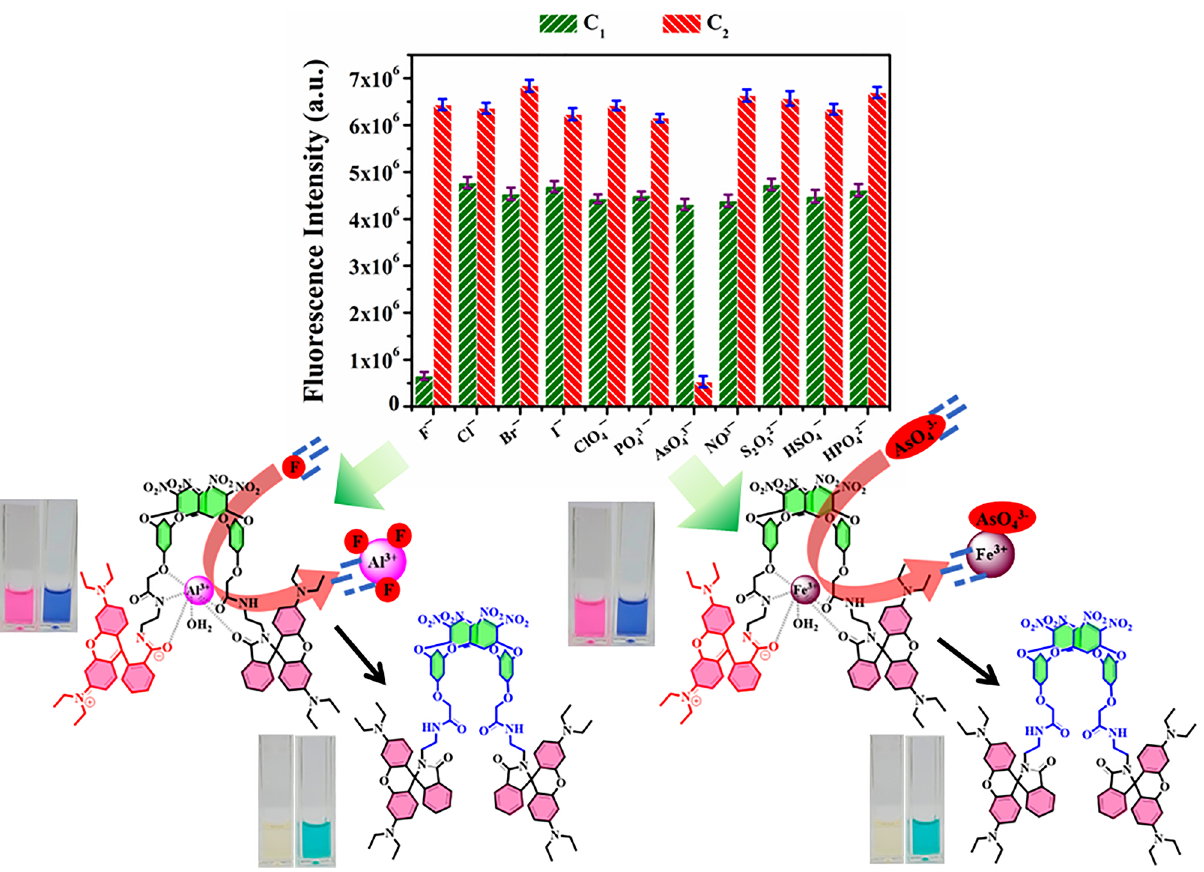
Figure 5. Variation in emission responses of C 1 and C 2 against a series of common anions in aqueous medium (top); a pictorial representation of fluoride and arsenate anion interacts C 1 and C 2